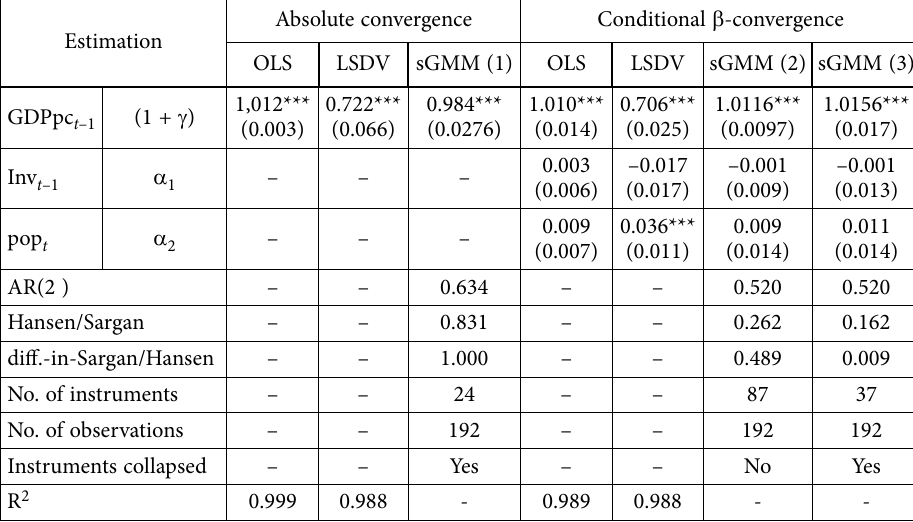
Table 4. Income convergence in Polish regions 2004–2015 (source: own calculations)